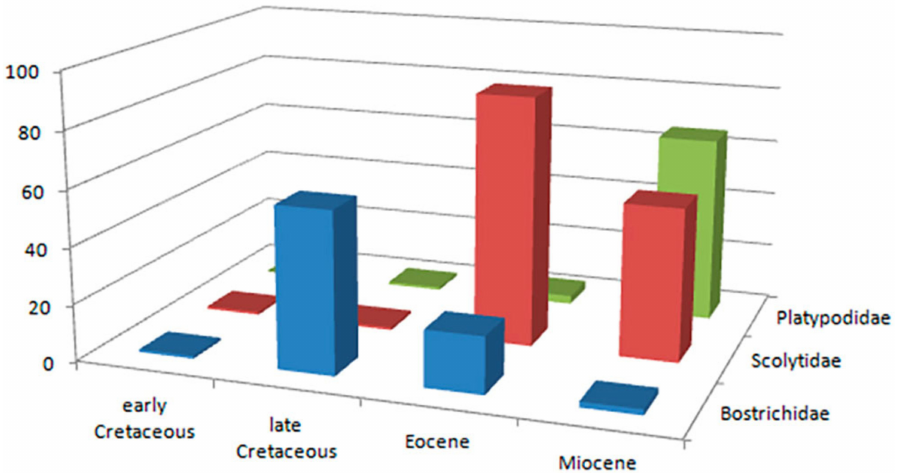
Figure 5. Number of auger, bark, and ambrosia beetles in the fossil record.